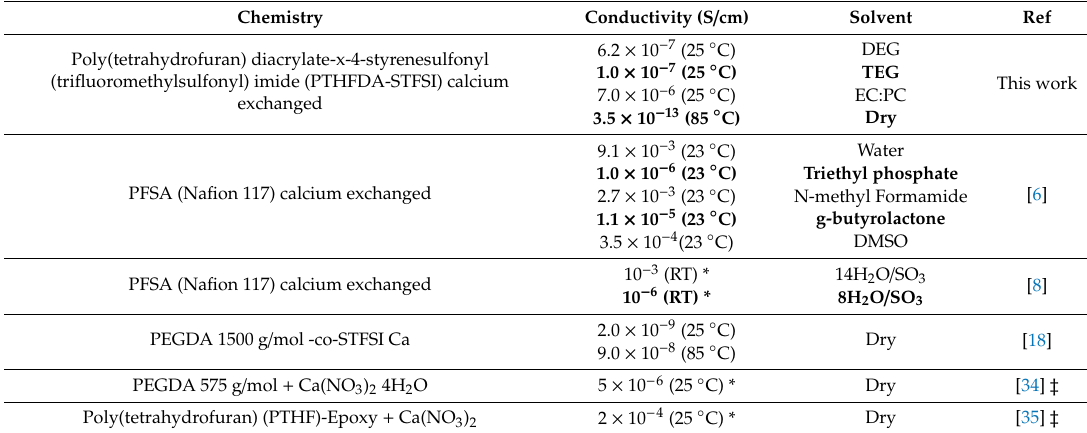
Table 3. Conductivity of calcium exchanged single-ion conducting polymers, along with select dual ion conductors, reported in the literature. * denotes value was estimated by visual inspection of plot. ‡ denotes dual-ion conductor. Bolded font is for visual